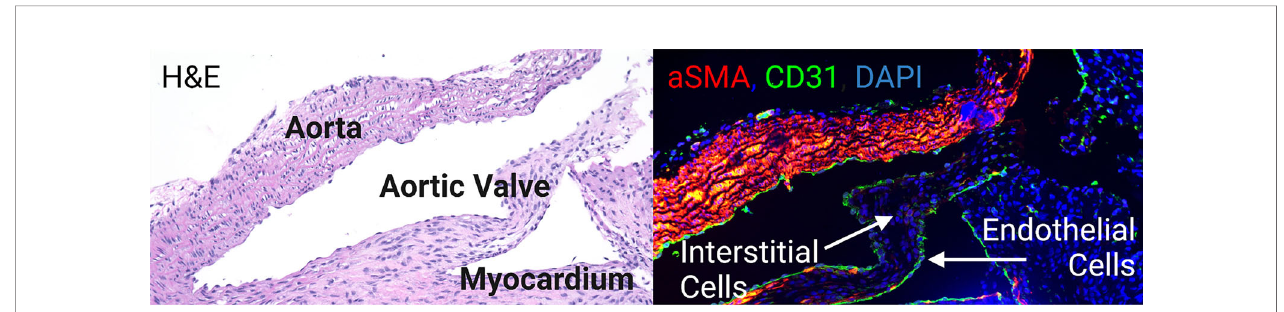
FIGURE 2 | The aortic valve is in continuity with the aorta and the myocardium. It is composed of an endothelial lining and an interstitial